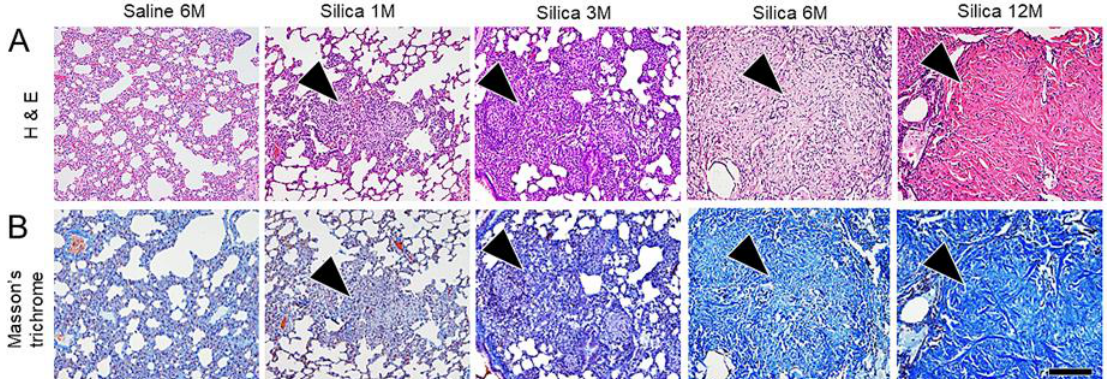
Figure 2. Microscopic findings of the serial lung tissue sections stained with hematoxylin and eosin stain (H & E) ( A ) and Masson ’ s trichrome ( B ). Time-dependent fibrosis characterized by progressive massive fibrosis with the formation of silicotic nodules (arrow heads) is observed in the lung of the treated rats. Bar = 150 μm. M: Month.